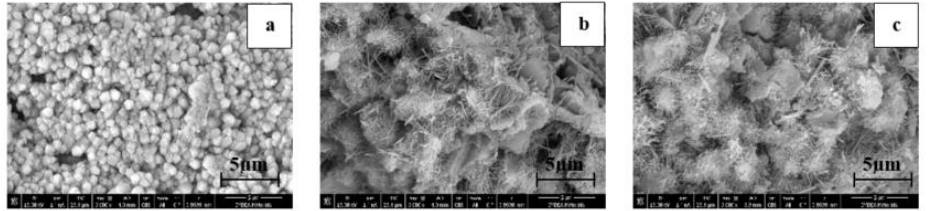
Figure 2. SEM micrographs 7 days after the preparation of ( a ) control sample, ( b ) 0.02 wt.% MWCNTs reinforced sample and ( c ) 0.02 wt.% SWCNTs reinforced sample.